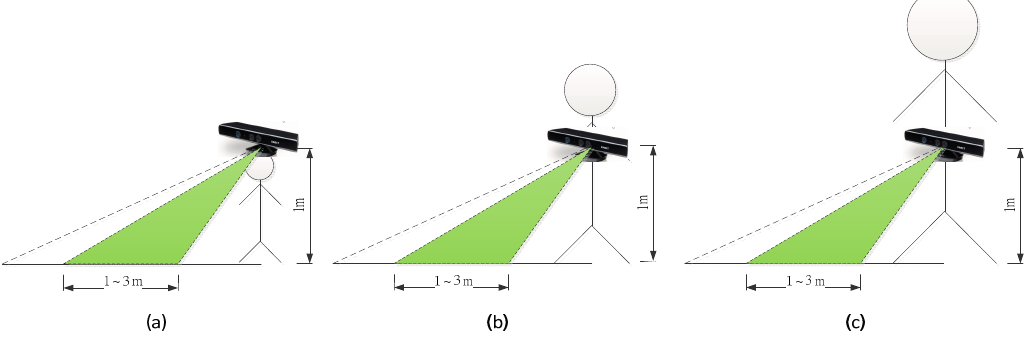
Figure 20. The Schematic diagram of the Kinect configuration for different stature person. ( a ) A short person; ( b ) A medium stature person; ( c ) A tall